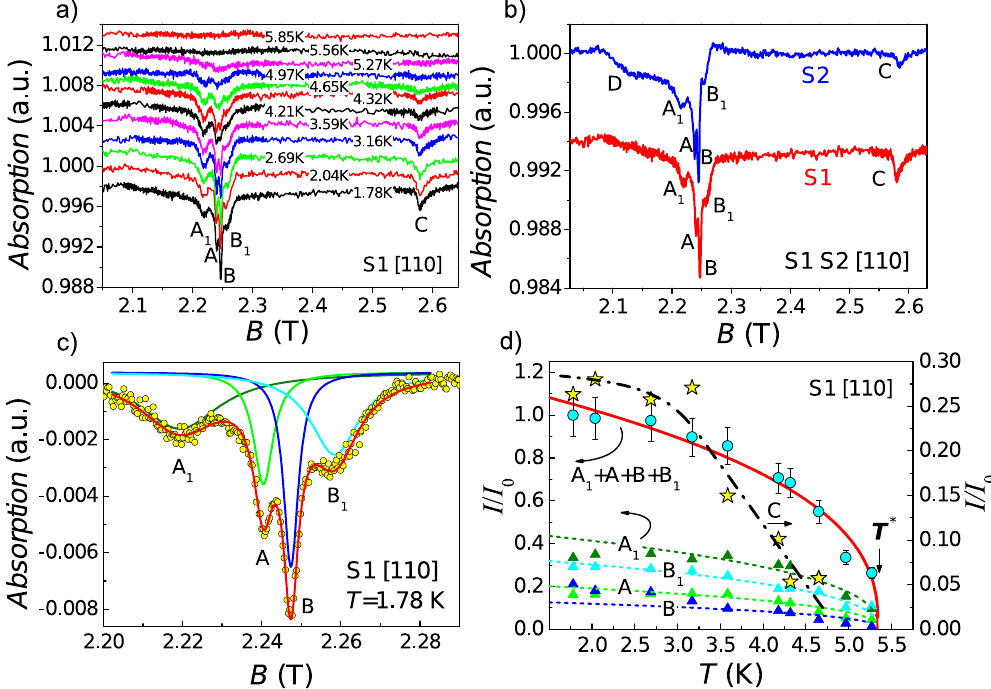
Figure 2. Temperature evolution of the resonant magnetoabsorption spectra for the S1 state of [110] surface of SmB 6 ( a ); effect of surface treatment ( b ); line shape analysis for the main paramagnetic signal in the S1 state ( c ) and the temperature dependences of the integrated intensities for various spectral components ( d) , see text for